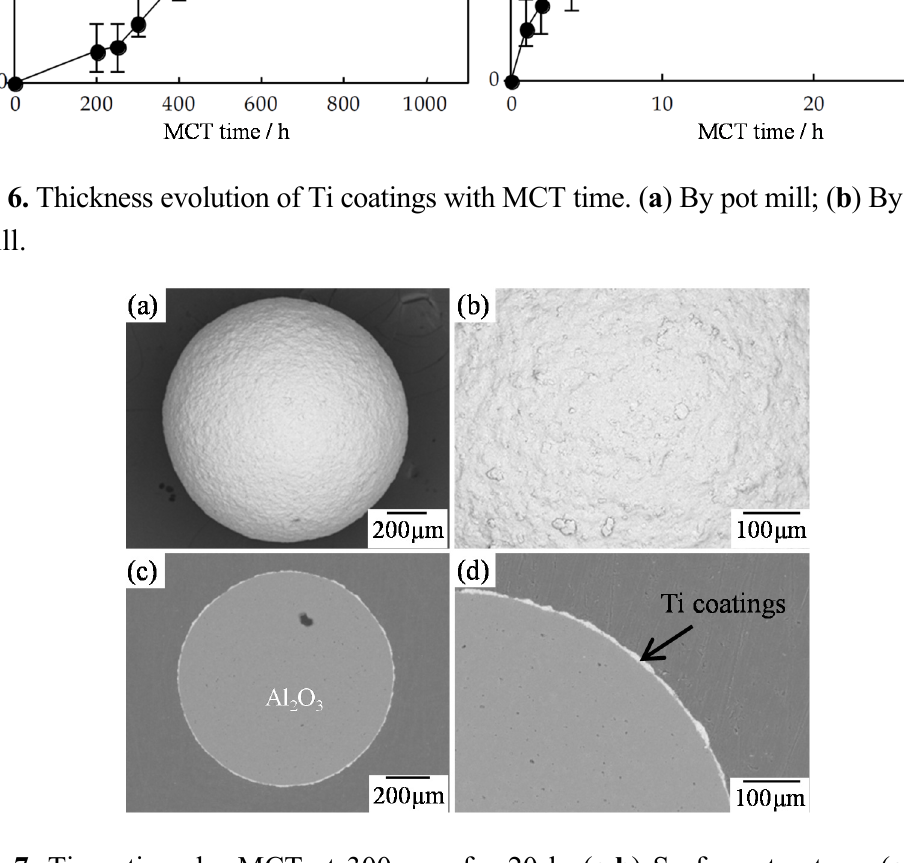
Figure 7. Ti coatings by MCT at 300 rpm for 20 h. ( a , b ) Surface structure; ( c , d ) Cross sectional